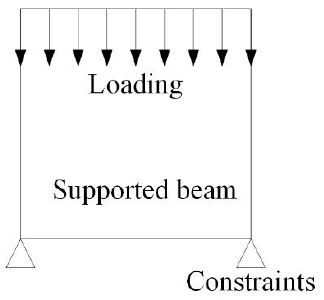
Figure 8. Model constraints and loading.